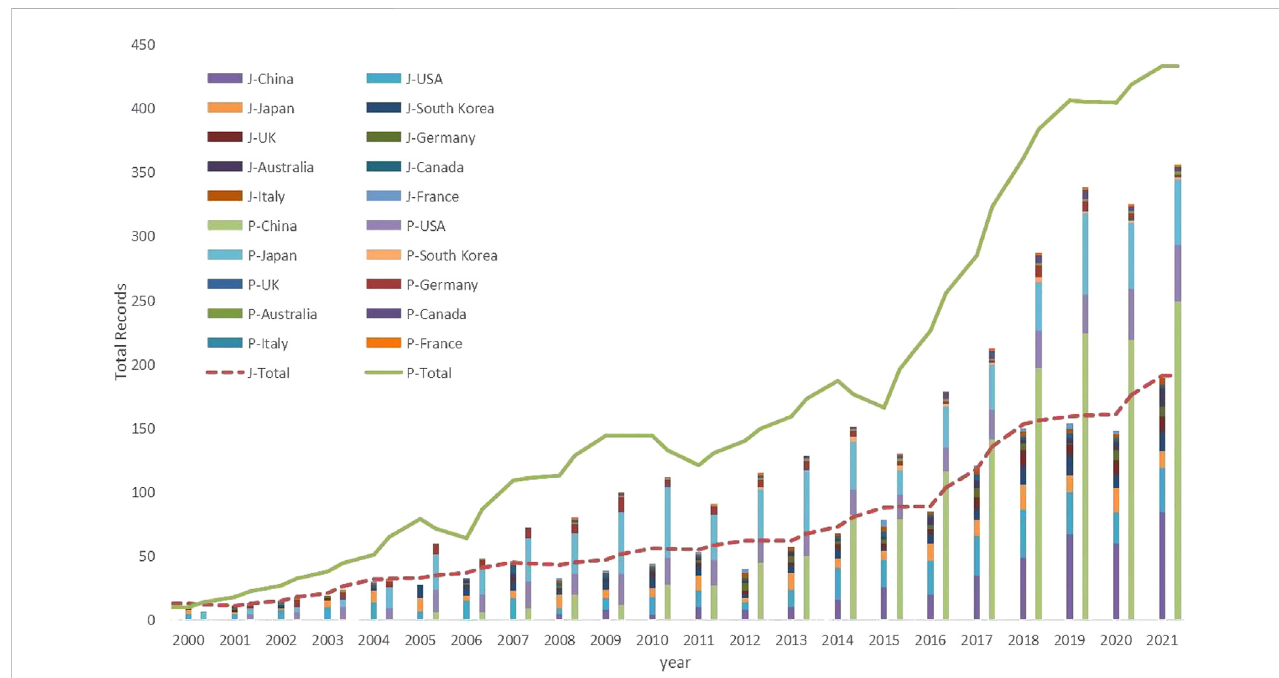
FIGURE 1 Theglobalproductionofarti fi cialmusclescienti fi candtechnologicalinnovationandtop10productive countries/regionscontributionsbyyear.Note(s): J-refers to the output of research papers, and P- refers to the output of technology